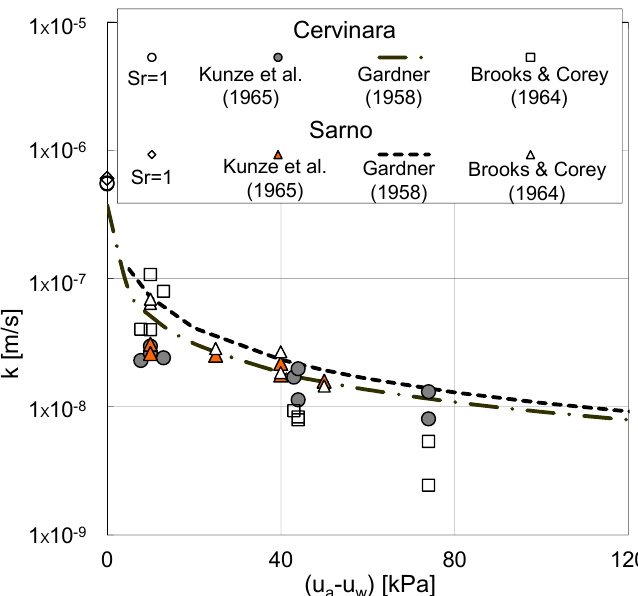
Figure 7. Permeability functions in suction-controlled triaxial (SCTX) tests; suction equalization in isotropic compression tests.